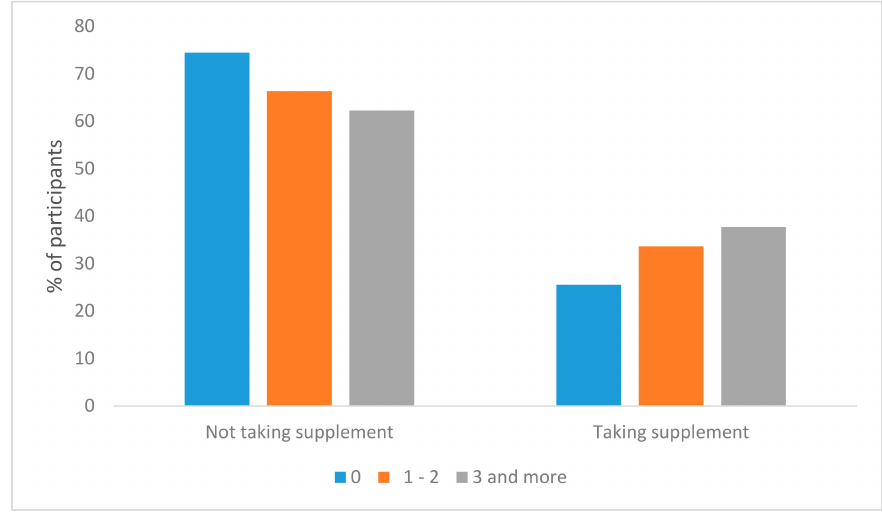
Figure 3. Supplement intake with respect to physical